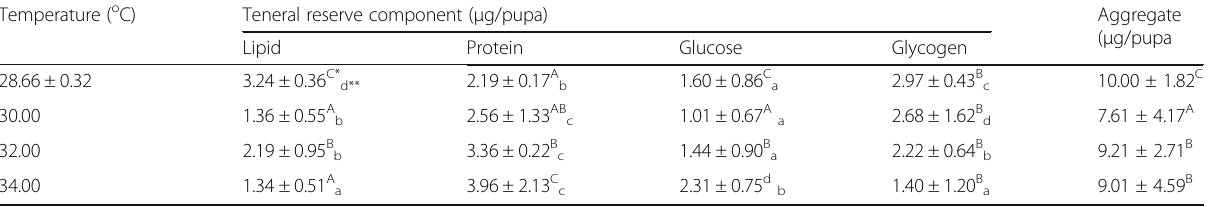
*Within a column, means (±SD) followed by same capital letter are not significantly different at p <0.05 according to Duncan multiple range test following analysis of variance (ANOVA). **Within a line, means (±SD) followed by same small letter are not significantly different at p <0.05 according to Duncan multiple range test following